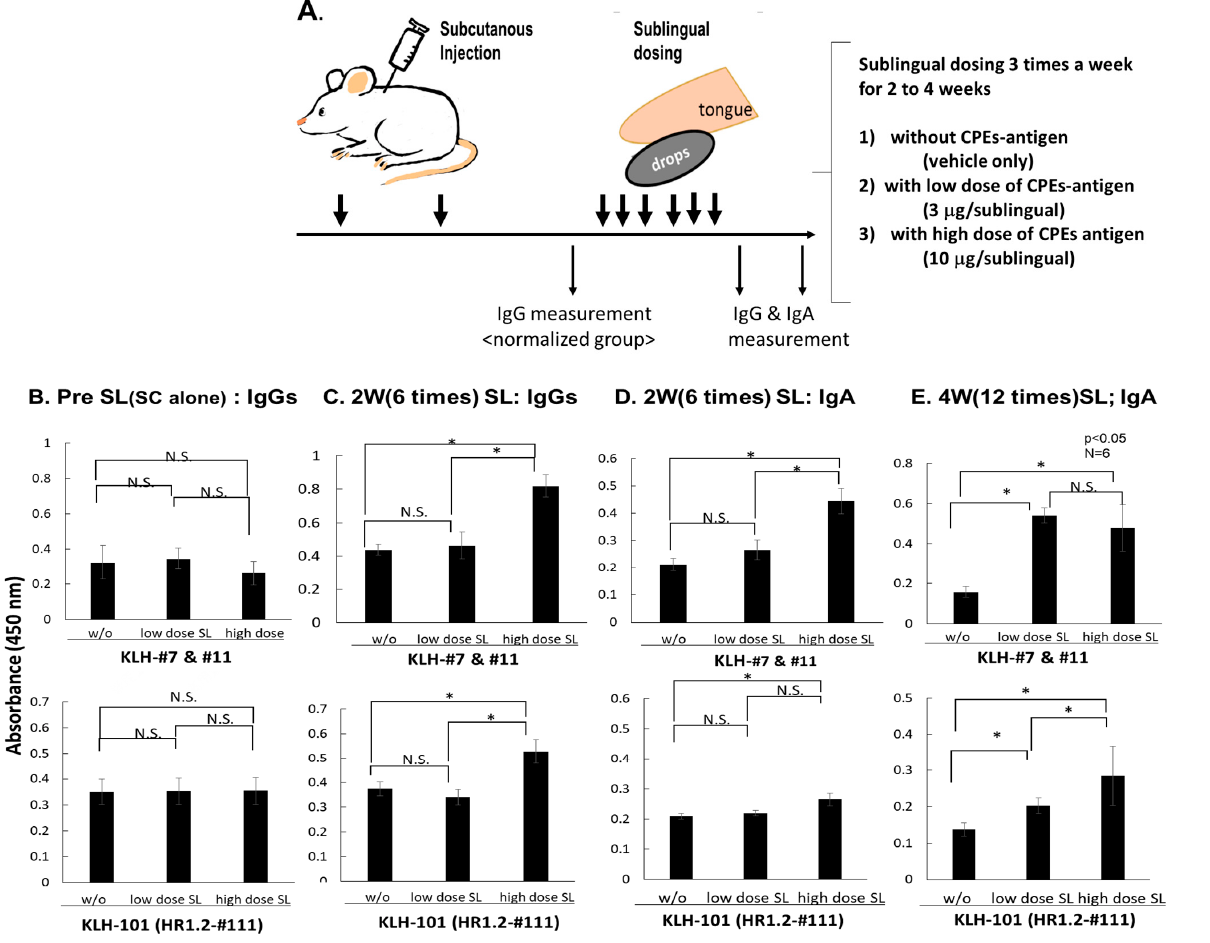
Figure 4. Enhancement and induction of IgG and IgA Abs-specific to nAb-epitopes by SL boosting of CPE-Ag. ( A ) Experimental scheme of SL dosing after 2 times SC administration to assess if Abs- specific to these CPE-Ags can be enhanced. The experimental design is shown. Mice were immun- ized by SC route with CPE #7 + #11 + #111-conjugated antigens (CPEs-OVA) at the dose of 3 μ g or 10 μ g/mice and administered again 2 weeks later. ( B ) Further 2 weeks after 2nd dose of SC immun- ization, mice were divided into three groups with similar IgG titers specific to CPE #7 + #11-conju- gated KLH and CPE #111-conjugated KLH, such that the mean IgG values of the three groups were not significantly different each other. The SL drop solution was applied under the tongue and stood for 1 min. This SL administration was repeated 3 times a week for 2 weeks and 4 weeks. The Ab- recognition towards CPE #7, #11 and #111 were shown before ( B ) and 2 weeks ( C , D ) after starting SL boosting in mice immunized with mixed CPEs-antigens via SC route. ( E ) IgA-responses were further analyzed after 4-weeks with SL dosing. N.S. means not significant each other, and asterisk (*) means statistically significant each other with p -value <0.05.